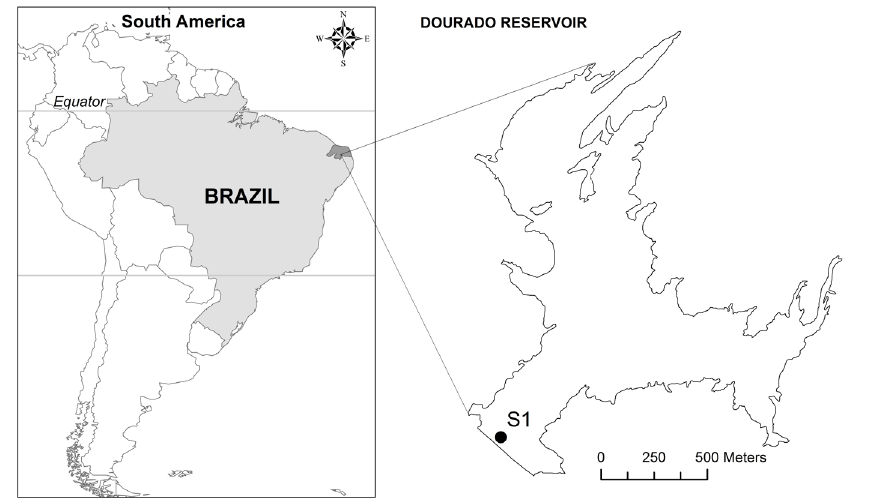
Figure 1. Location of Dourado man-made lake and sampling station right next to the dam